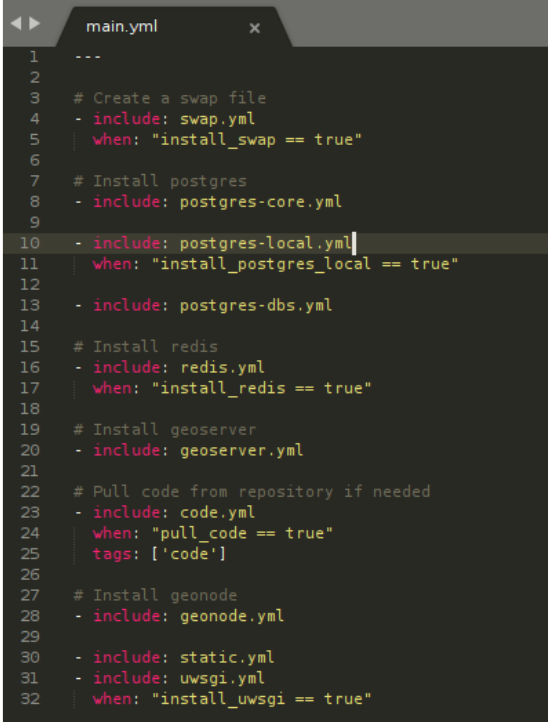
Figure 6. The main Ansible script for full stack setup. Each yml included in the file contains specific steps for component set up.